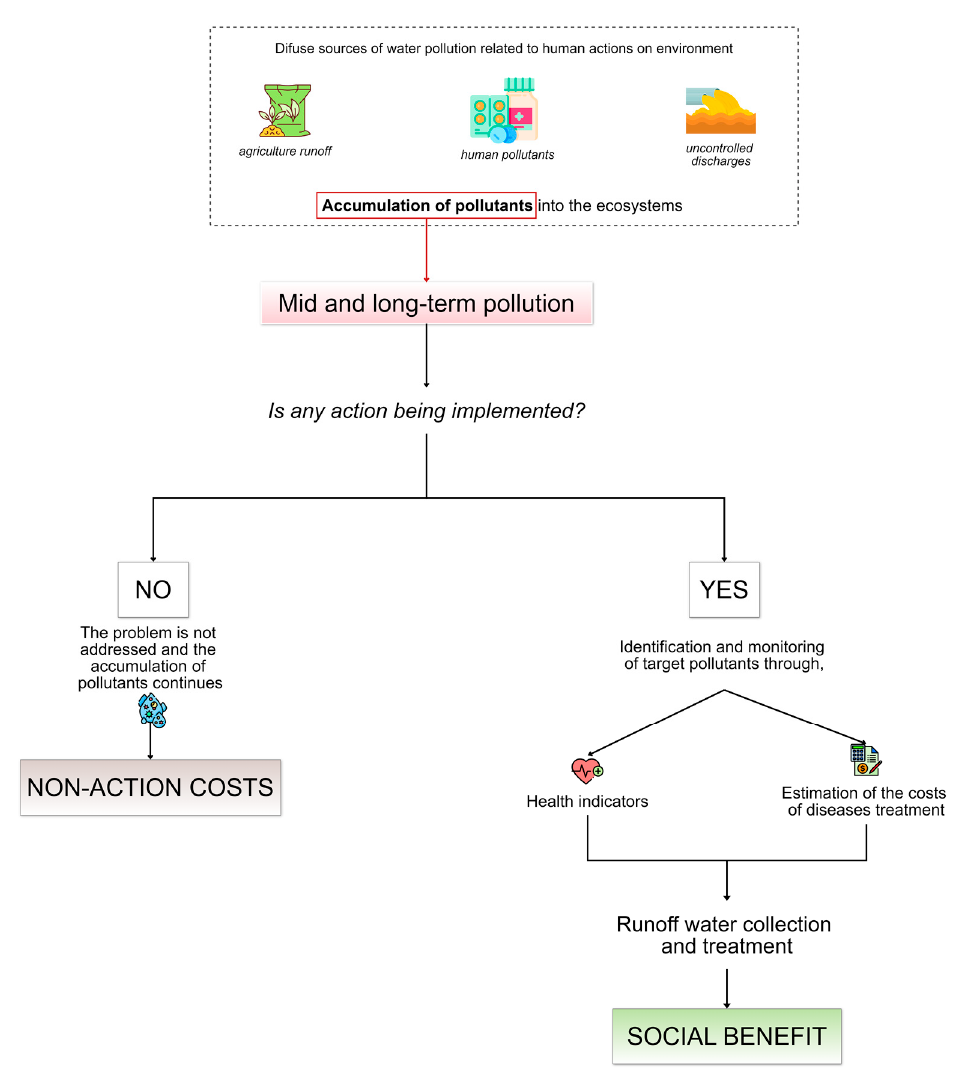
Figure 1. Non-action-cost approach. Source: own elaboration. Table 3. Steps of non-action cost assessment. Source: own